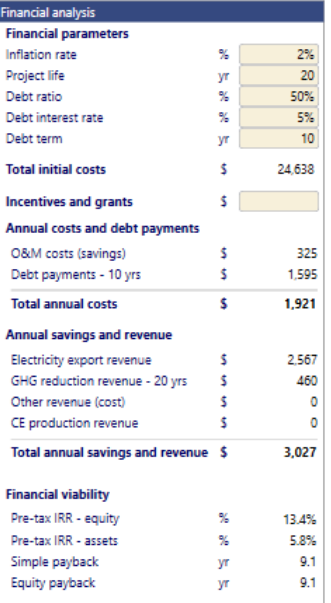
Figure 9. Financial inputs in the case of London, United Kingdom.